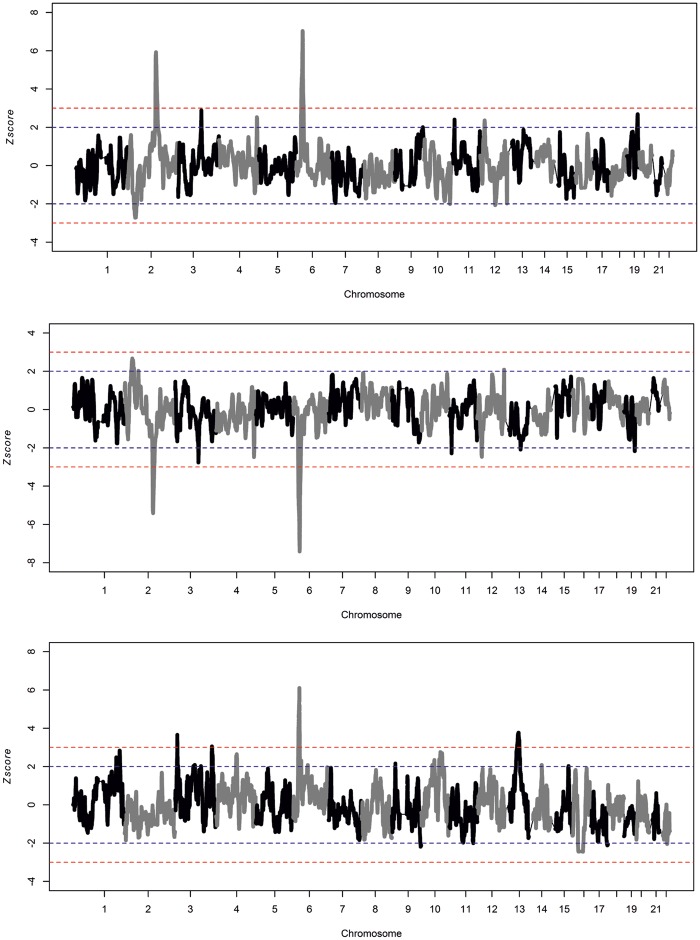
Genome-wide Z-score scan of ELAI local admixtures in Canary Islanders for NAF (top), EUR (middle), and SSA (bottom). Horizontal broken lines (blue > |2|; red > |3|) indicate score thresholds.